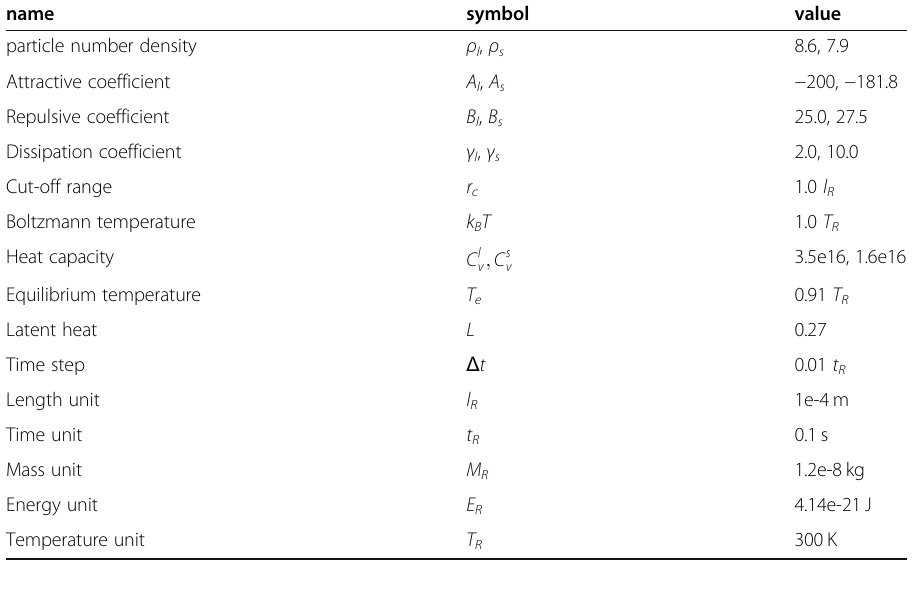
Table 1 MDPDE related